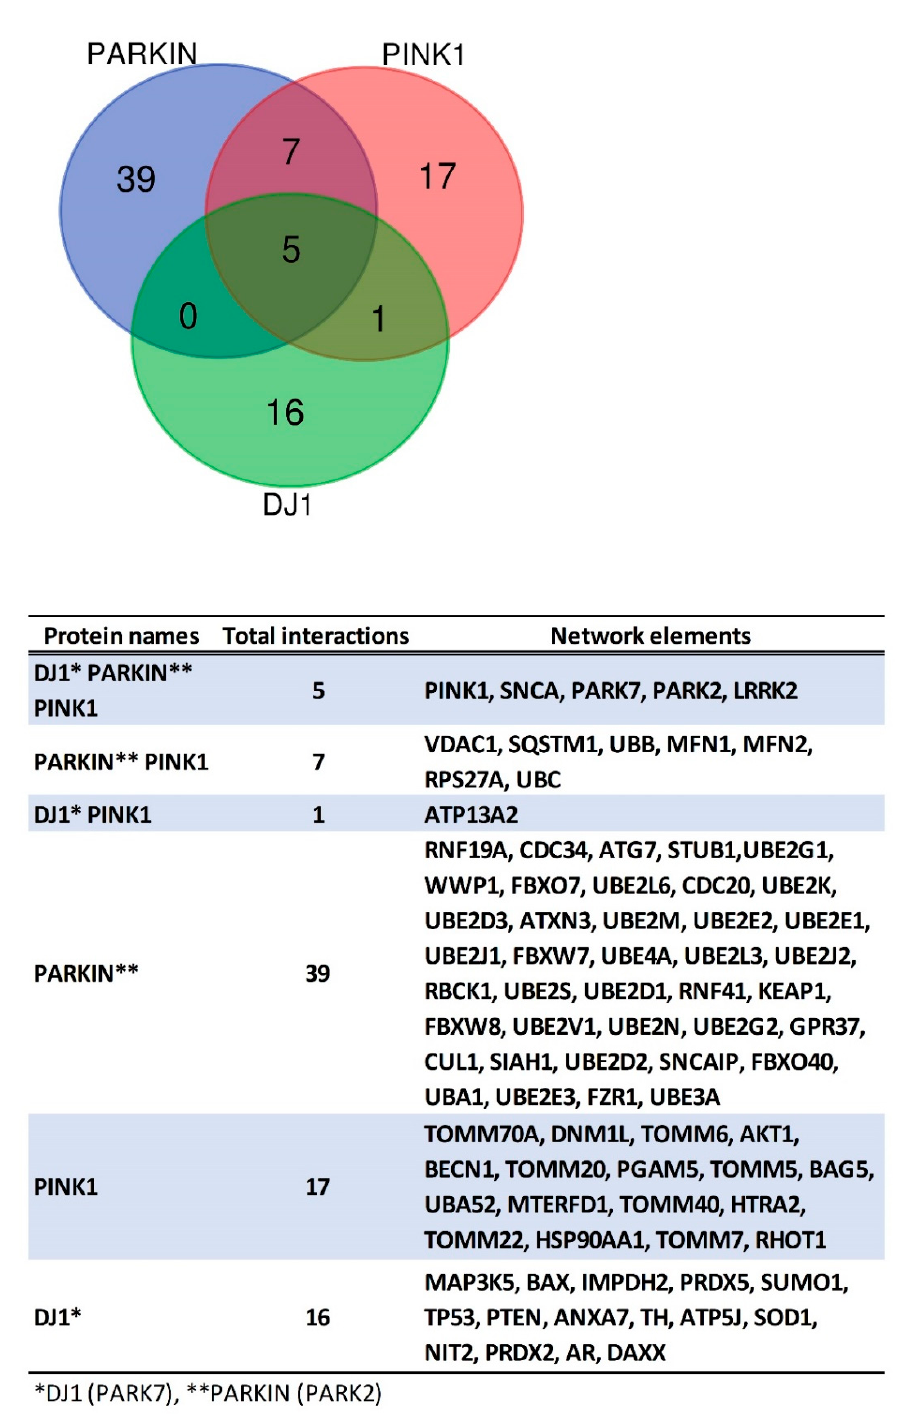
Figure 5. Venn diagram of PINK1/PARKIN/DJ-1 network. This was created with the Bioinformatics and Evolutionary Genomics tool.